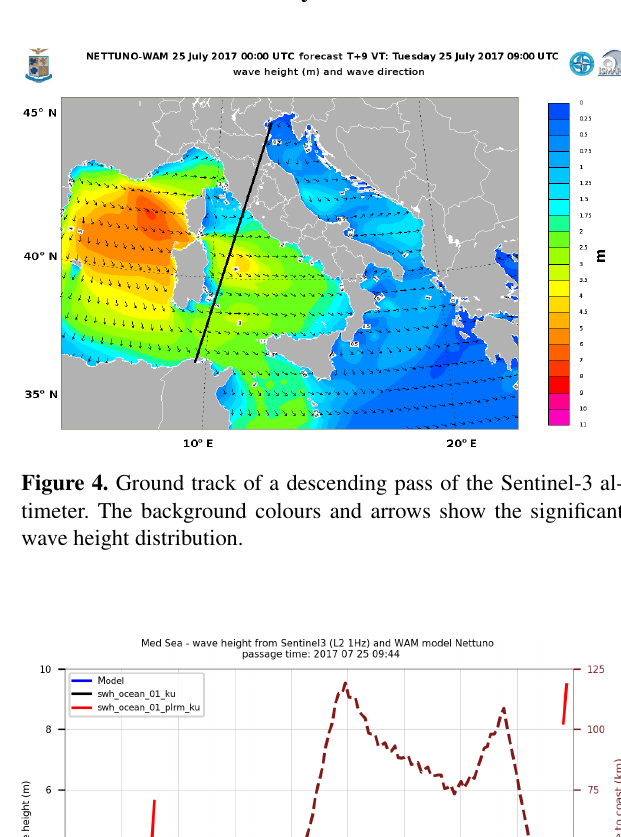
Figure 6. Detailed geometry, focused on the Adriatic Sea, of the area of the pass shown in Fig. 4 and (in more detail in) Fig. 7. The positions and the corresponding SAR mode (swh_ocean_01_ku) al- timeter significant wave height values are also shown (in metres).